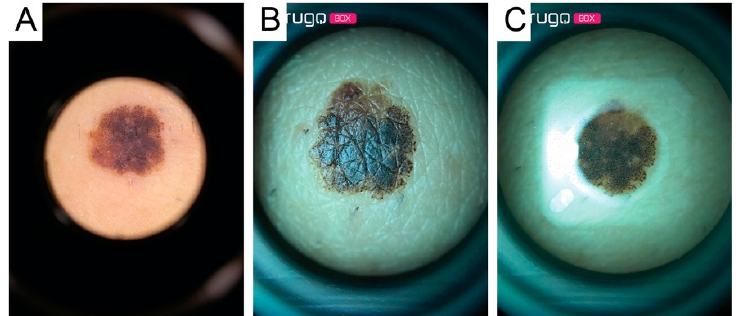
Figure 3. ( A ) Example of original image; ( B ) Example of original image with Hough transform result; ( C ) Cropped image.